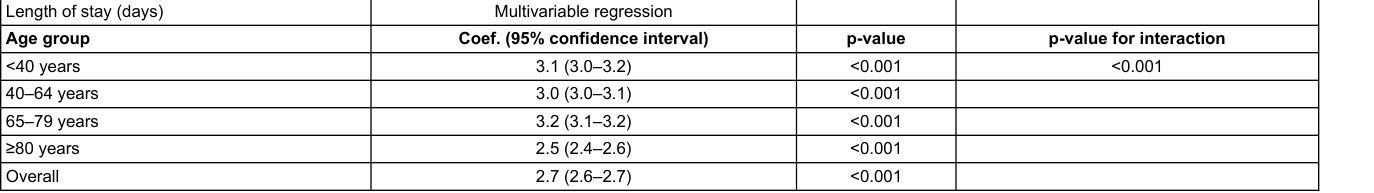
Table S2: Multivariable regression analysis for length of hospital